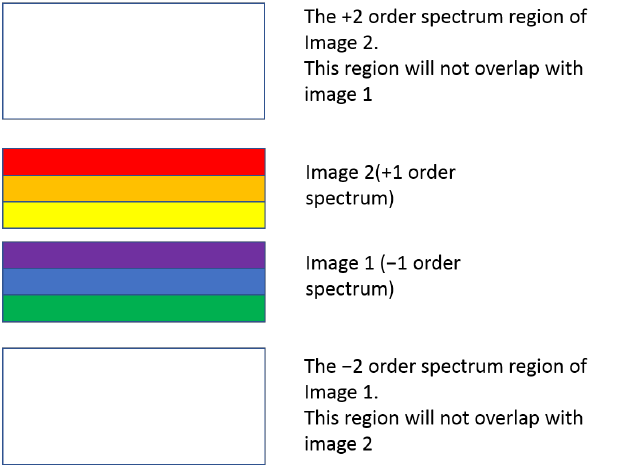
Figure 7. Image 1 and image 2 adopt − 1 order and +1 order respectively, which can prevent the influence of high-order spectrum.